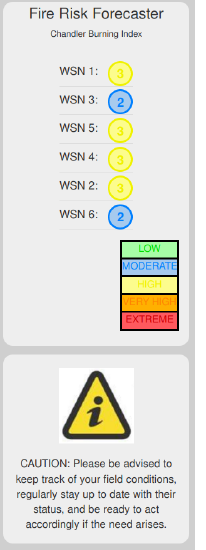
Figure 15. F.E.MO.S. indication regarding the case of a high fire risk scenario in one or more